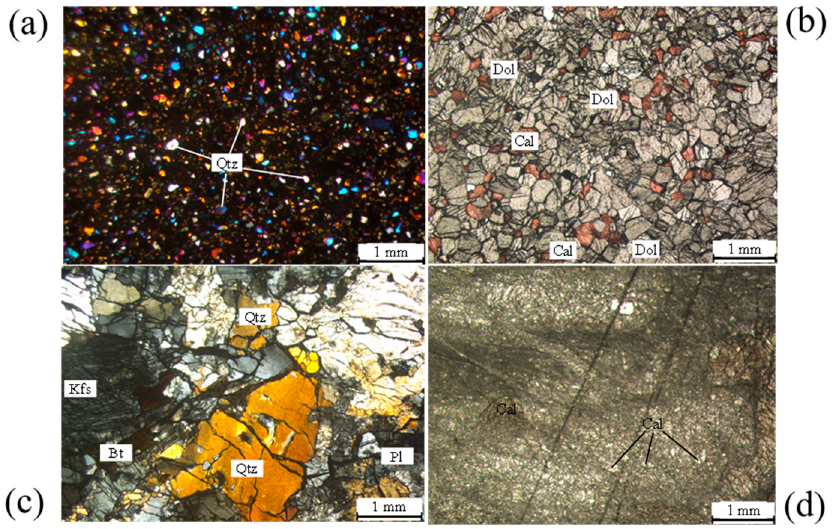
Figure 8. Microstructure of rocks obtained from transparent refractive index experiment. ( a – d ) Red sandstone, marble, granite, and limestone, respectively. Qt—quartz; Dol—dolomite; Cal—calcite; Kfs—potash feldspar; Bt—biotite; Pl—plagioclase [58].